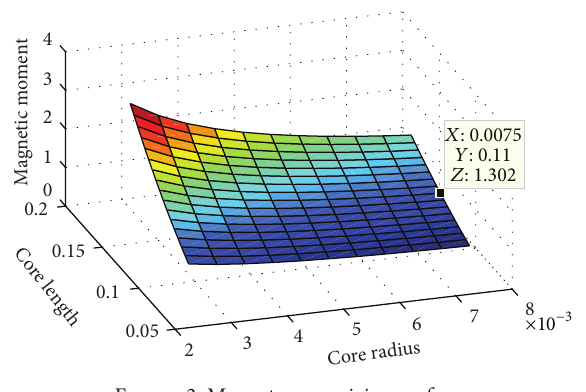
Figure 3: Magnetorquer sizing surface. Table 1: Magnetorquer parameters.